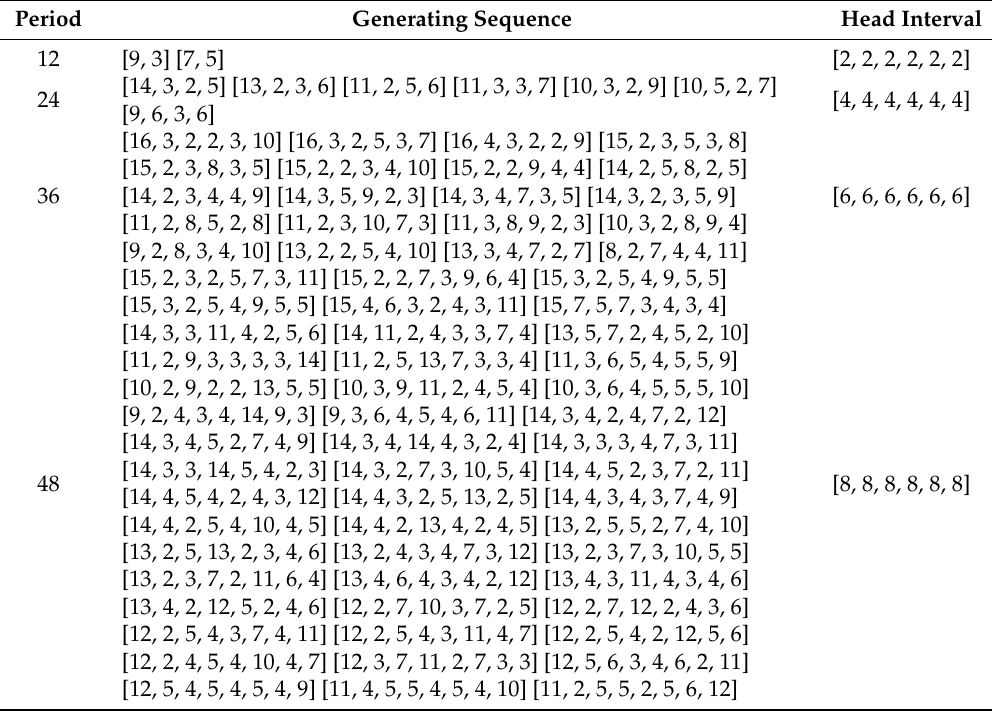
Table A1. Complete result of length 6 necklace ordering